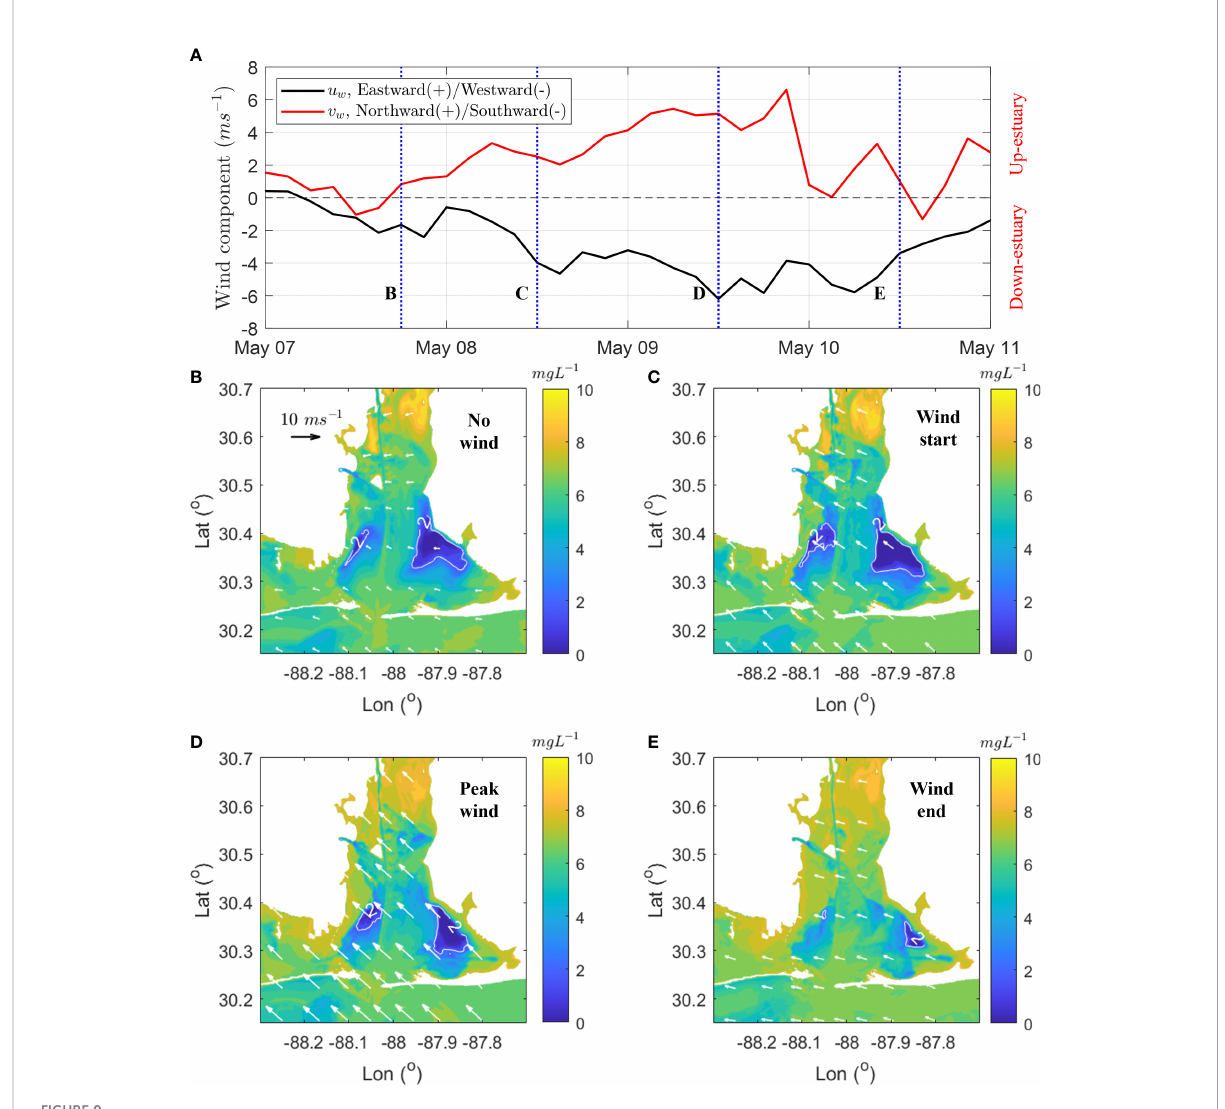
FIGURE 9 Evolution of bottom DO during a southeast wind event on May 8 – 10. (A) solid lines are 3-hourly averaged raw wind-speed in the center of Mobile Bay (data from NARR) and blue dashed lines denote times corresponding to different phases of the wind event shown (B – E) . (B – E) Snapshots of the evolution of bottom DO concentration over the southeast wind event: (B) event initiation, (C) event onset, (D) event peak, and (E) event end. White arrows show magnitude and direction of wind, and the solid white contour lines show the boundaries of the hypoxic